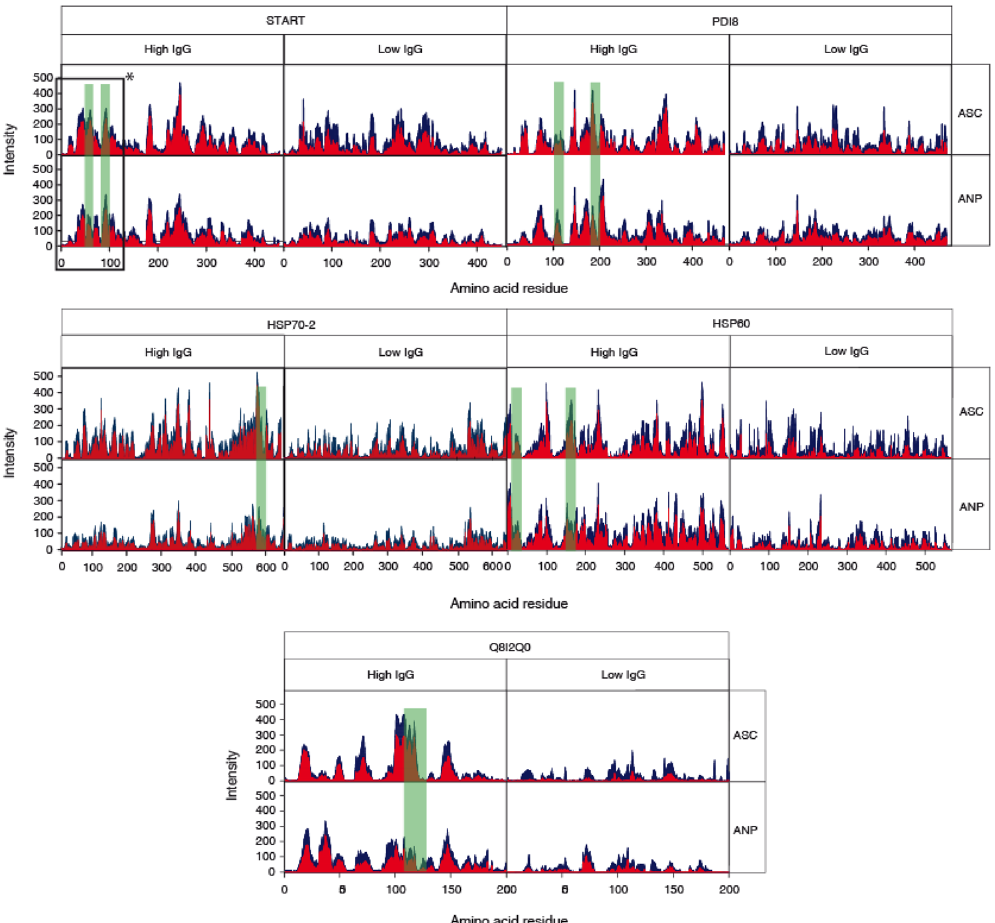
Figure 1. Epitope mapping in the five P. falciparum antigens. Data was recorded from 15-mer microarrays of overlapping peptides covering the whole protein sequence. Data shows average fluorescence m (blue) and standard error ( s ) subtracted average fluorescence m-s (red) along the sequence of the indicated antigens. Data is presented in a set of 4 plots to distinguish incubation with sera from ASC or ANP patients and for high IgG ( > 60 μ g mL − 1 ) and low IgG sera. n values are as follow: 10 for ASC/High IgG; 8 for ANP/Low IgG; 11 for ASC/ Low IgG; 9 for ANP/High IgG. The positions of the selected 20-mer peptides are shown as overlay green bars. Ratios of cumulative signal intensities to Pf-specific IgG were not significantly different between High and Low IgG groups: average values 7.6 × 10 − 3 ± 0.01 and 5.6 × 10 − 3 ± 0.01,